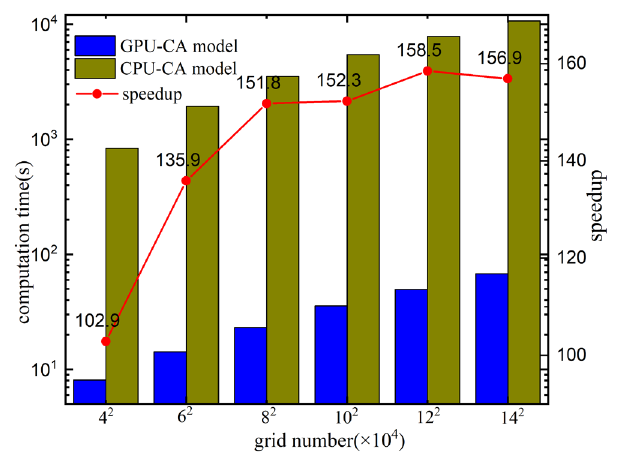
Figure 9. Computational